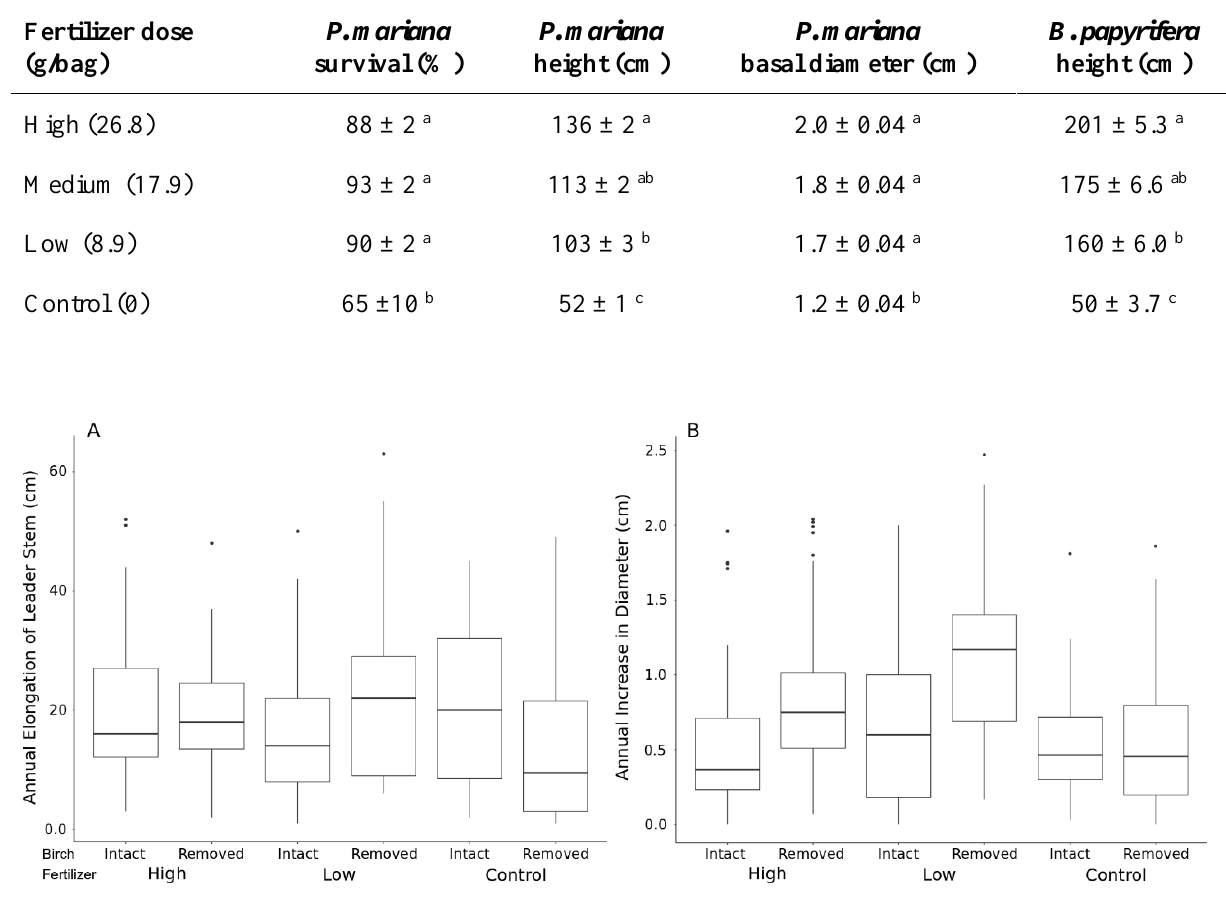
Table 2. Mean (± SE) of survival, basal diameter and height of P. mariana and height of B. papyrifera seven years after planting of P. mariana saplings in relation to their fertilization treatment. Doses are significantly different for a given factor if they do not share a common letter; statistical values are given in the text.